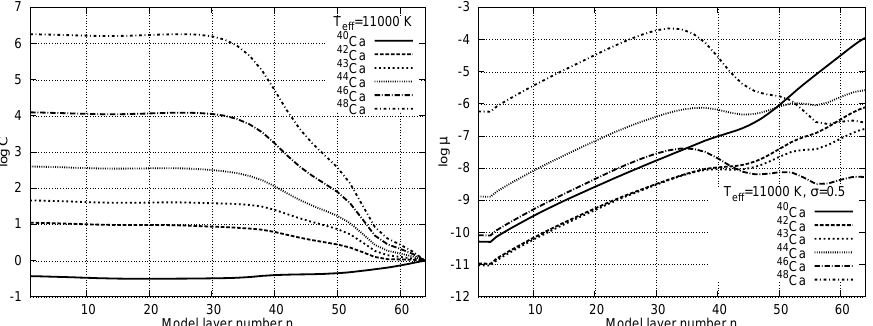
-1 Fig. 2. The same as in Fig. 1, but for T eff = 11 000 K. The mean value of the impact cross section is (cid:27) = 0 : 5 (cid:1) 10 (cid:0) 16 cm 2 .